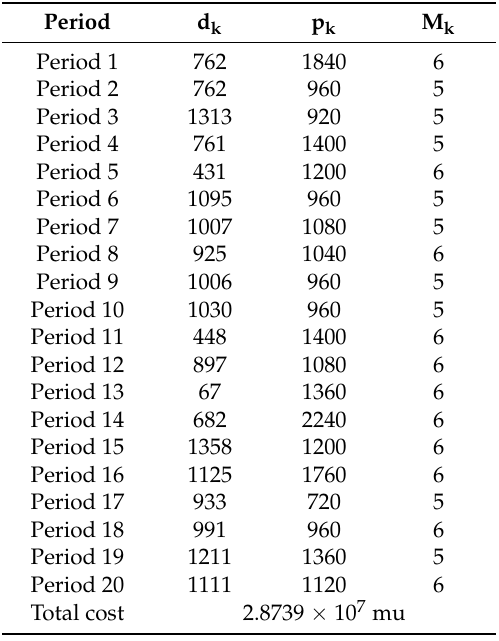
Table 5. Case 2: Production plan for individual maintenance policy.